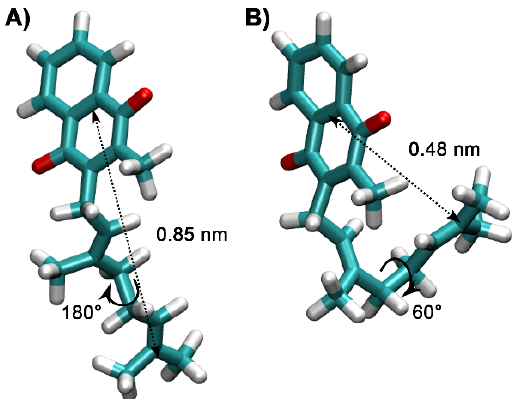
Figure 10. Two representative conformers observed for the MK-2 MD simulations in the POPC bilayer. Torsion around the C11-C12 bond modulates the distance between the terminal CH 3 -carbon labeled CT and the center of the quinone ring, termed here d(CT-H). Panel ( A ) shows a trans conformer with a long intramolecular distance and panel ( B ), a gauche conformer with a much smaller intramolecular distance.